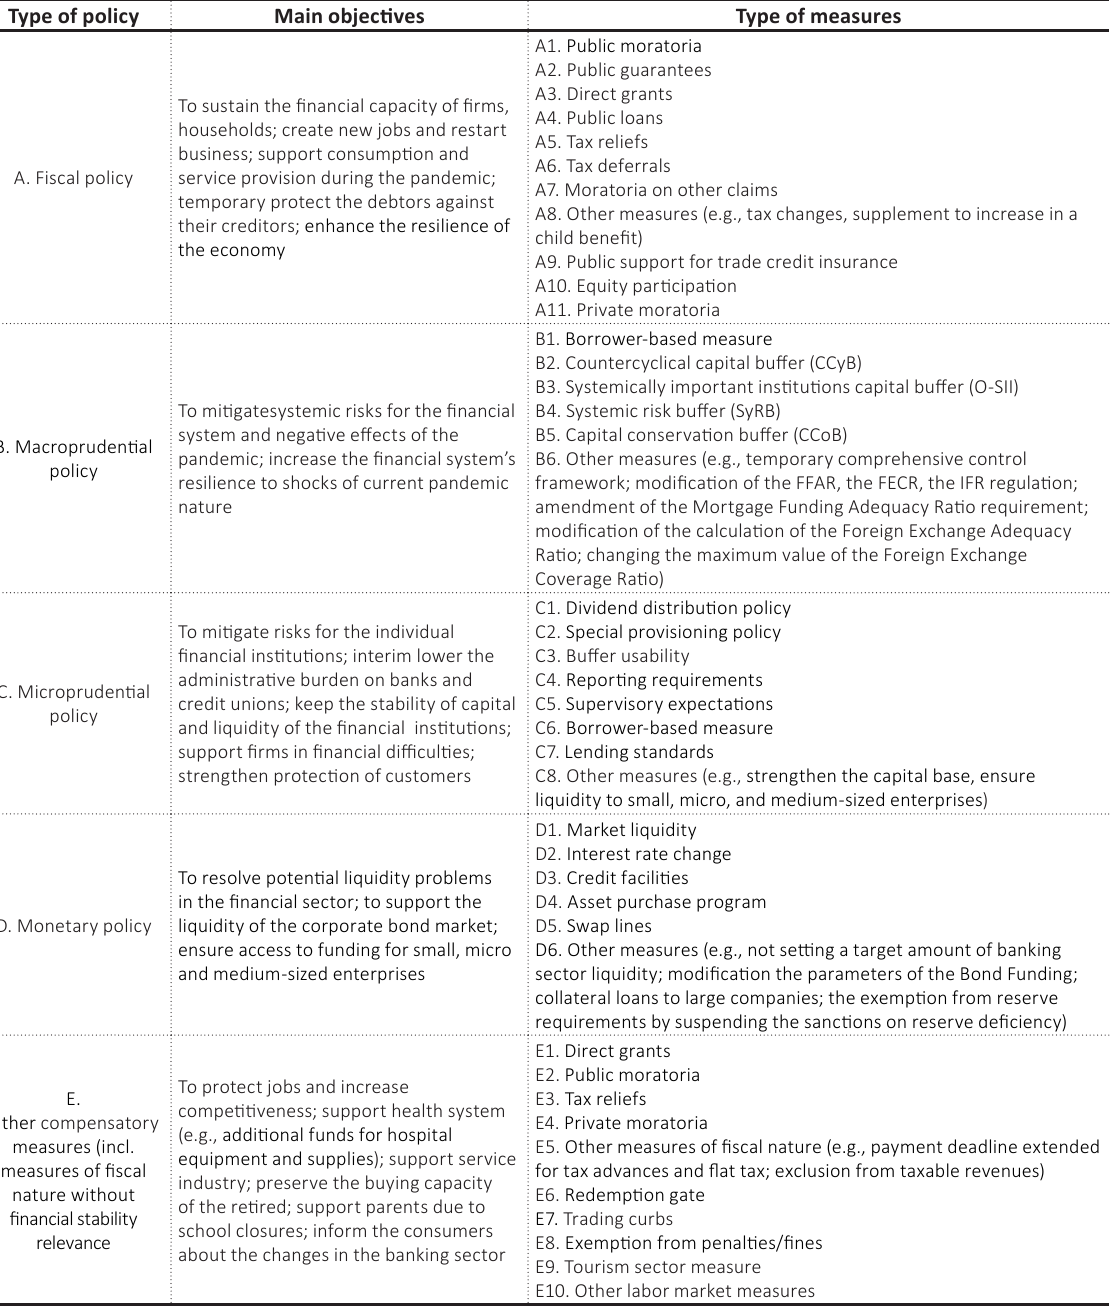
Source: ESRB (2021), IMF